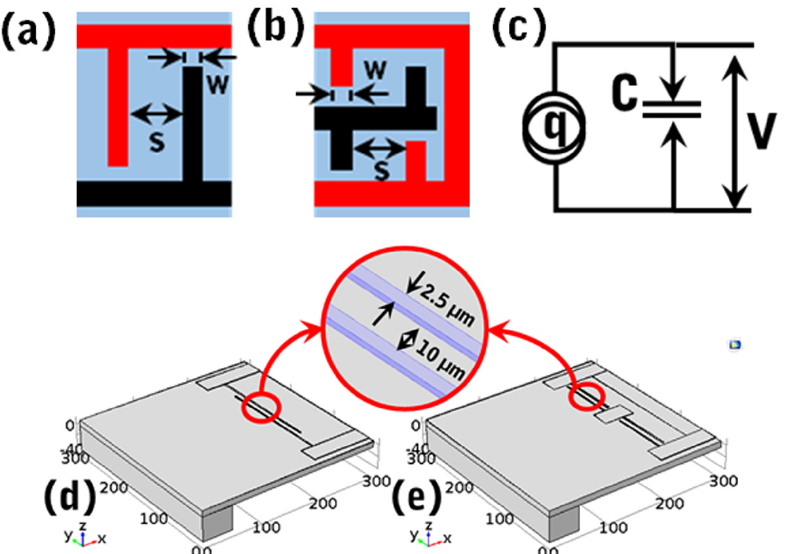
Figure 1. Modeling of D33 mode, ( a ) unit cell of regular D33 mode, ( b ) unit cell of proposed D33 mode, ( c ) equivalent piezoelectric circuit of a unit cell of the regular and proposed D33 modes, ( d ) computer-assisted design (CAD) modeling of unit cell of the regular D33 mode and ( e ) CAD modeling of a unit cell of the proposed D33